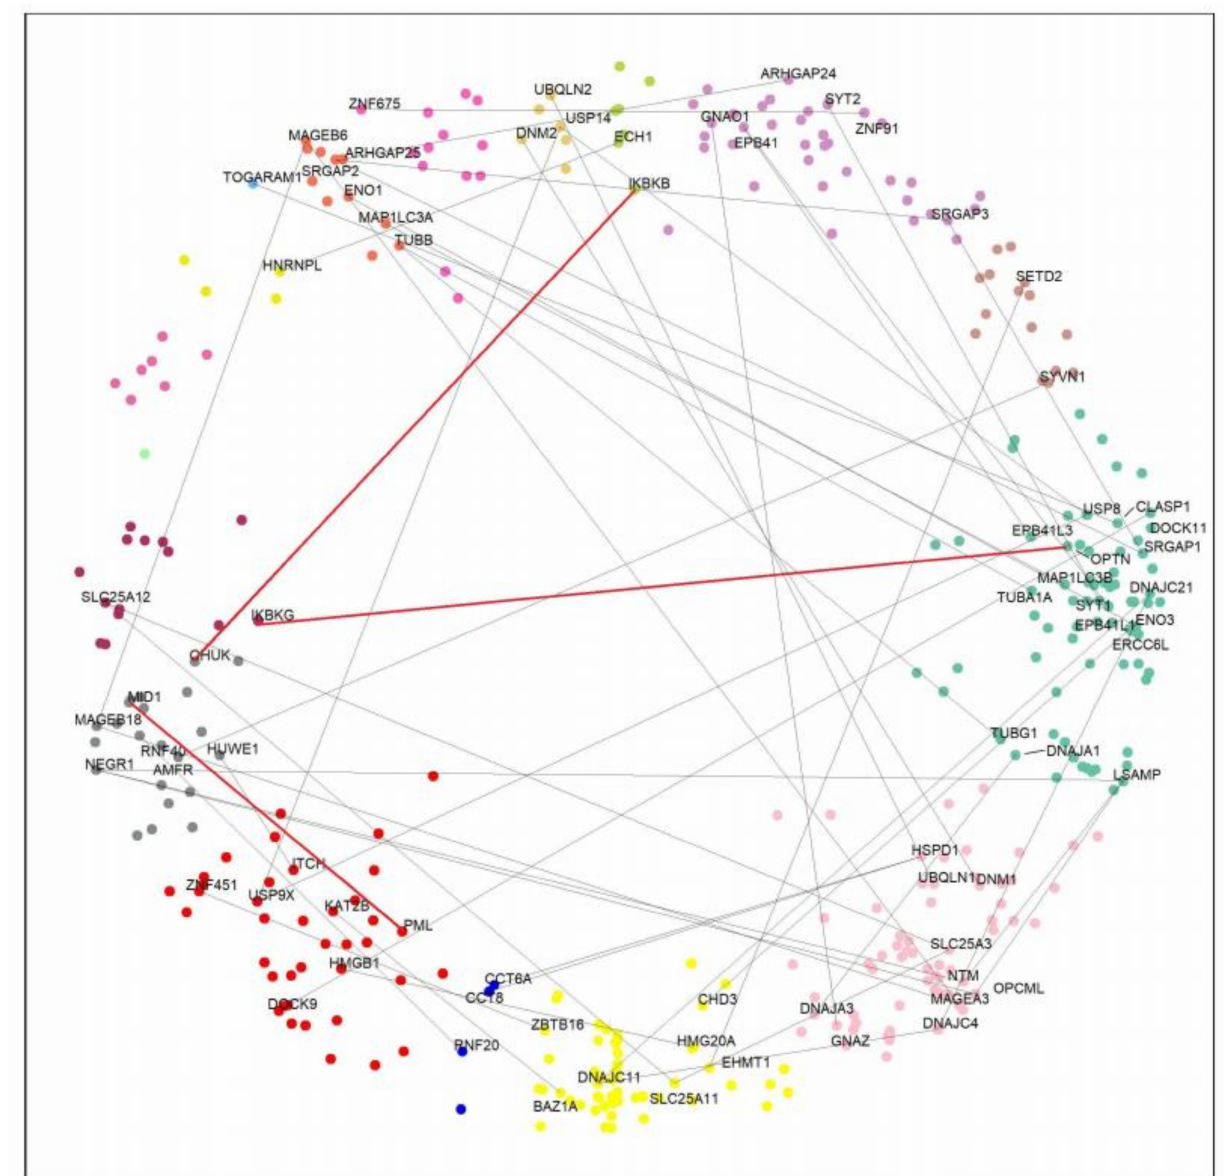
Figure 3. Paralog pairs of HTT interactors in different clusters. Nodes in different colors display protein agglomeration in angular similarity-based sectors. The nodes with the Gene Symbol represent the 49 paralog pairs located in different clusters. Paralog pairs are connected by an edge. Red edges indicate the three pairs of paralogs with opposite effects on HD (see text for